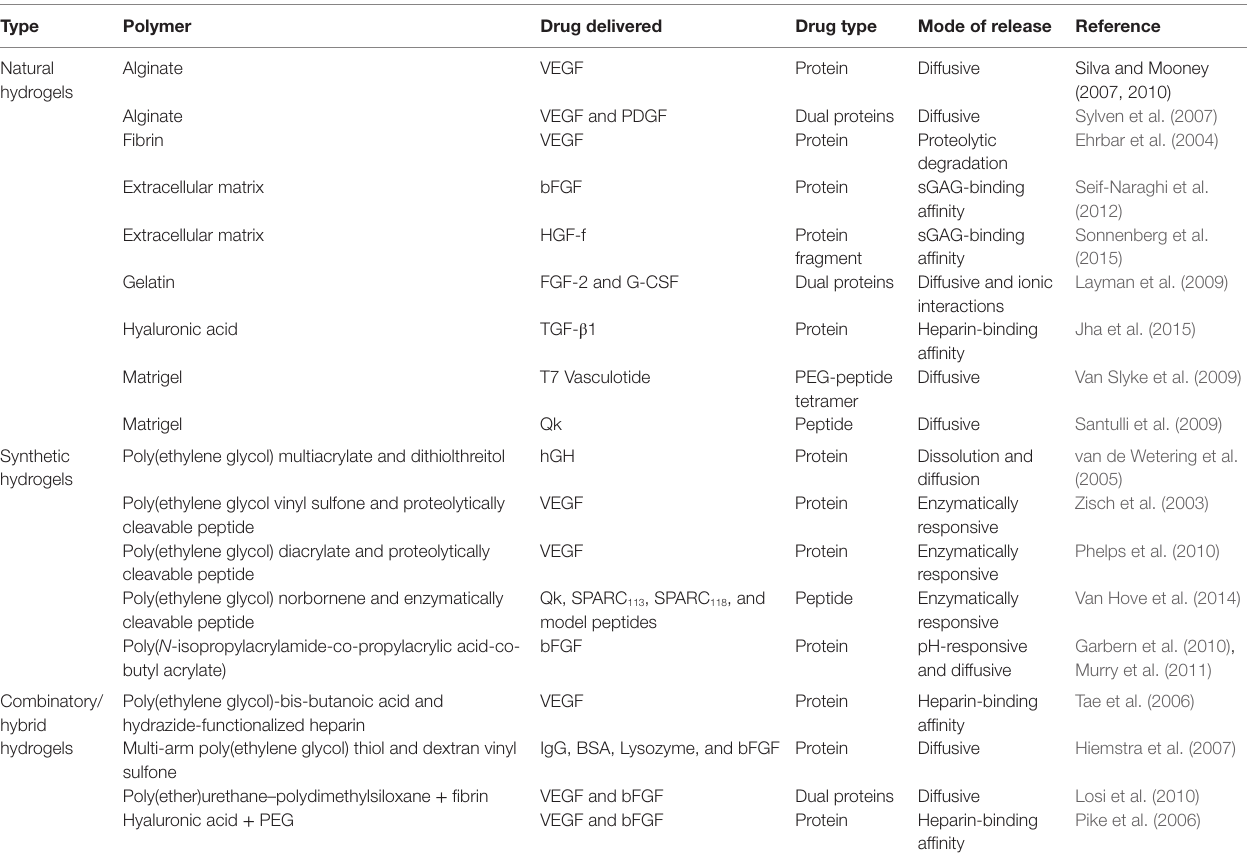
TABLe 3 | Hydrogel-based biomaterials for controlled drug